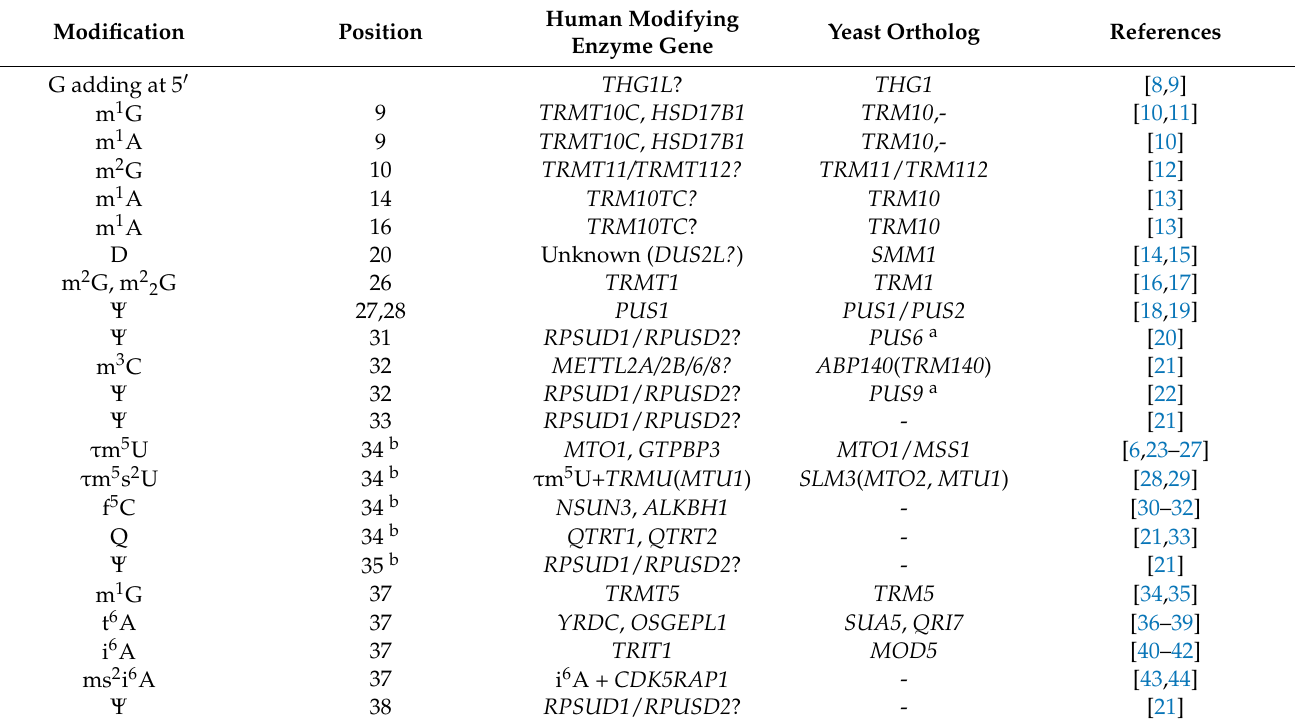
Table 1. Nucleotide modifications found in human mt-tRNAs, position of the modification, human gene(s) encoding for the modifying enzyme(s) and their yeast orthologs, if present. Human Modifying Modification Position Yeast Enzyme Gene